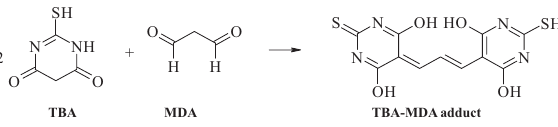
Scheme 1. The interaction between malonyldialdehyde and thiobarbituric